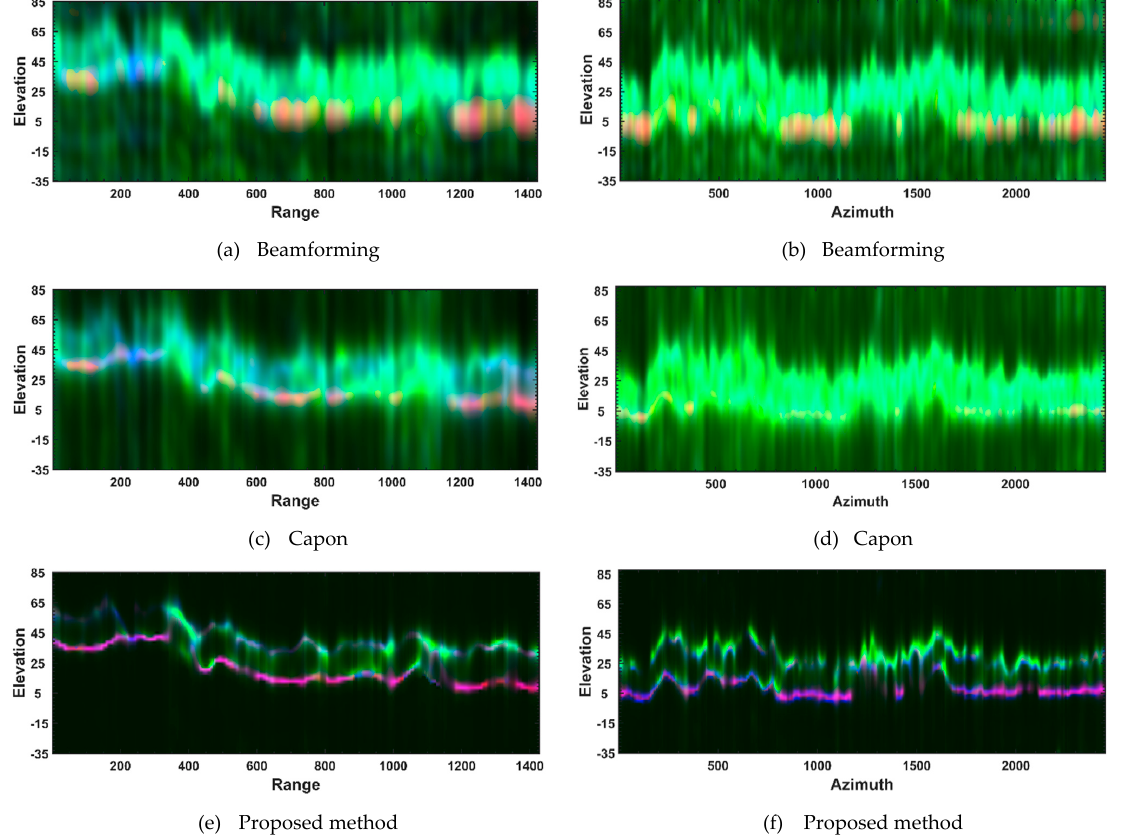
Figure 8. The color-coded Freeman-Durden tomograms of TropiSAR data set along a fixed azimuth line ( left ) and a fixed range line ( right ).